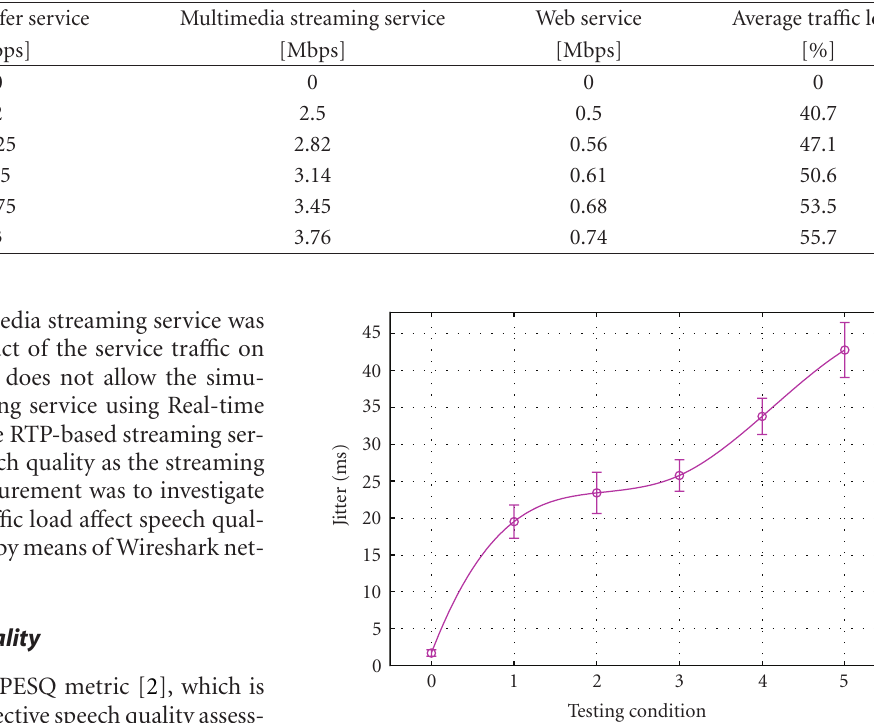
Table 2: Performance evaluation of testing conditions.